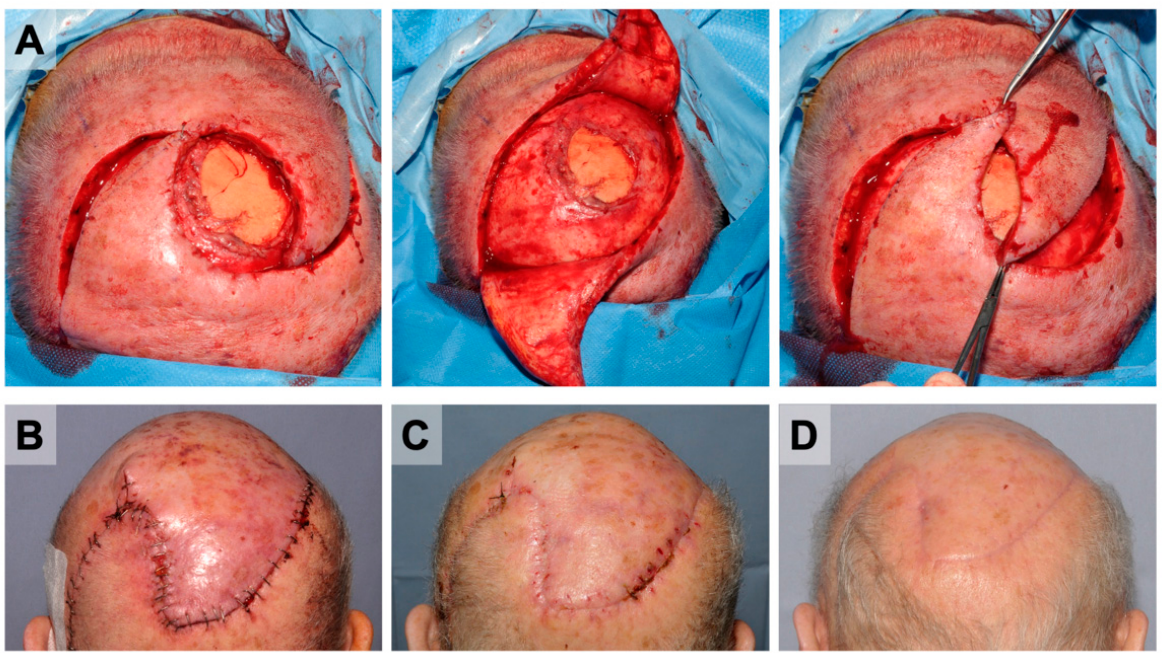
Figure 4. Yin-Yang flap for the scalp reconstruction after margin-free resection of an AFX. Presentation of a 78-year-old patient with AFX in the mid-scalp region in transition to the vertex. The tumor was resected, including the periosteum, in a first operation and temporally covered with synthetic skin replacement EpiGARD ® . ( A ) Within four days, tumor-free margins were confirmed, and coverage of the 29.5 cm 2 was performed by yin-yang rotation flap. The later course was uneventful. ( B ) The results on postoperative day 3, ( C ) one month after the surgery, ( D ) and at the 3-month control show the patient presenting with good wound closure and without complications or recurrence.